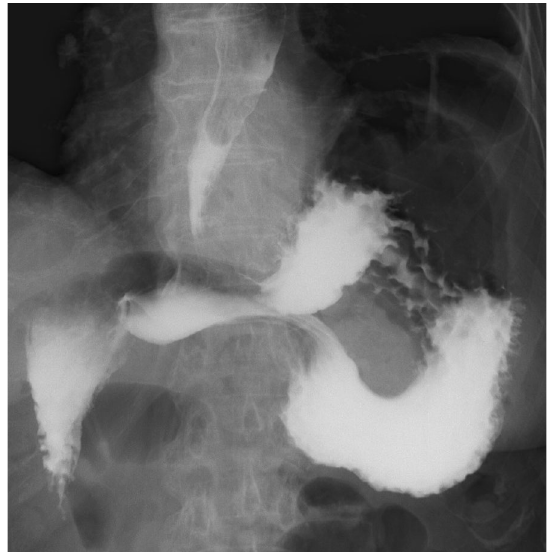
Fig. 6 A postoperative contrast-enhanced examination showed that the stomach had returned to normal position and there was no stenosis